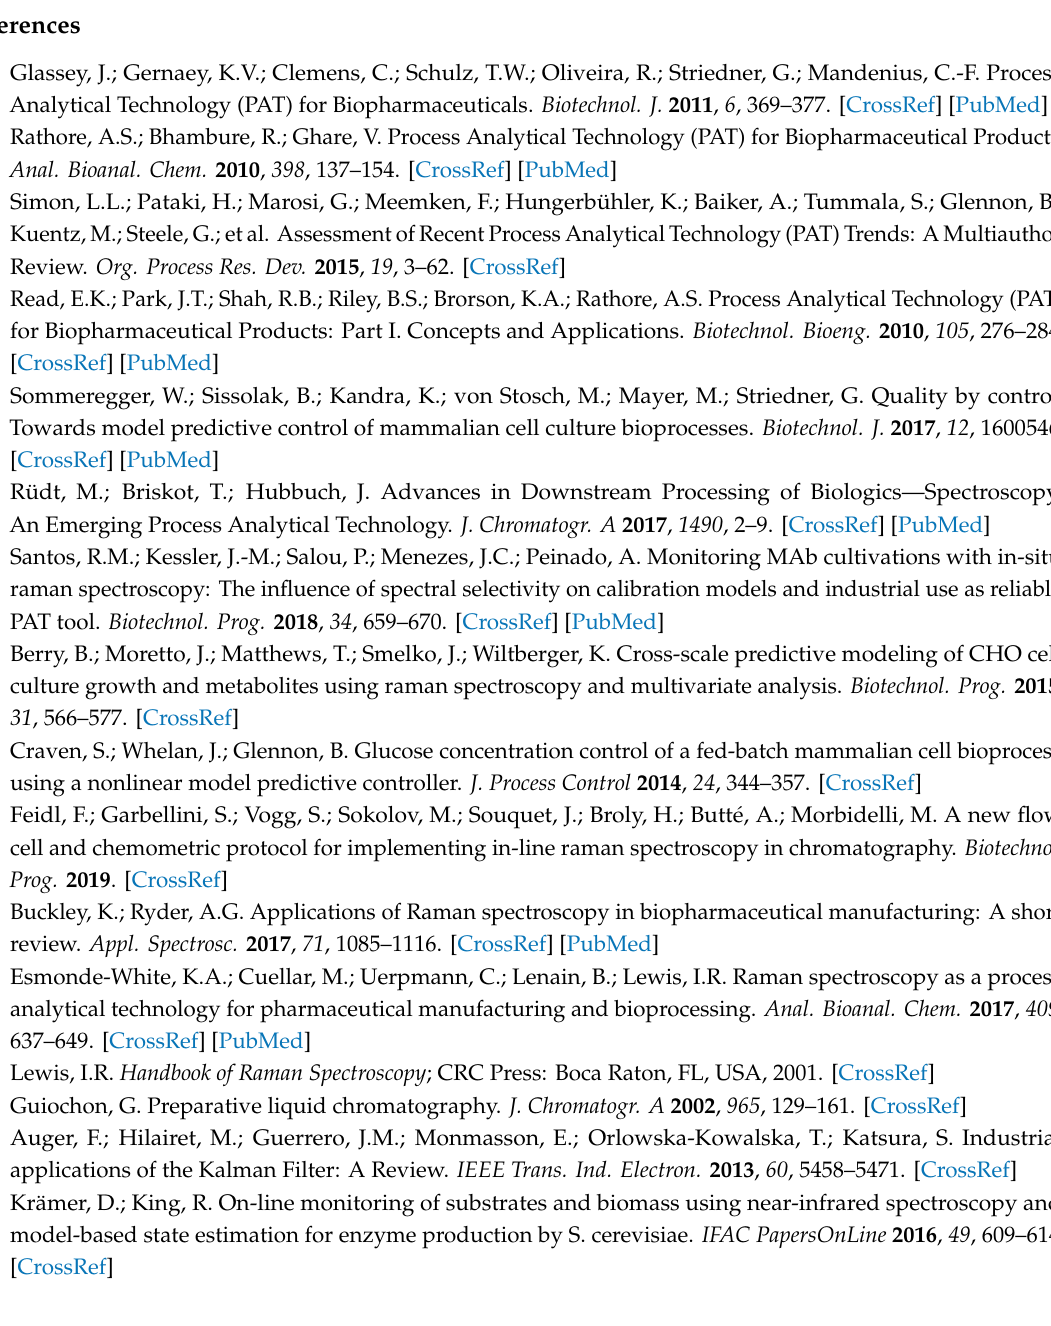
Figure S1: Acquired Raman spectra of the calibration set of